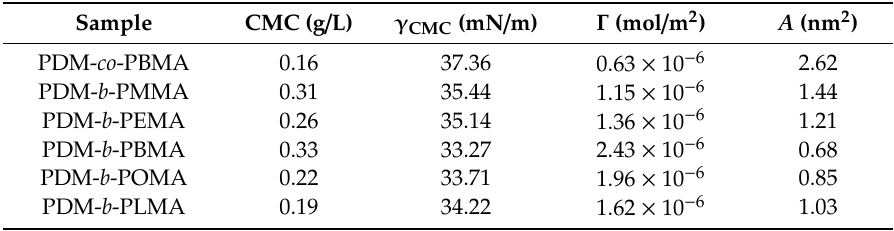
Table 3. Gas–liquid interface adsorption parameters of PDM- b -PRMA and PDM- co -PBMA.